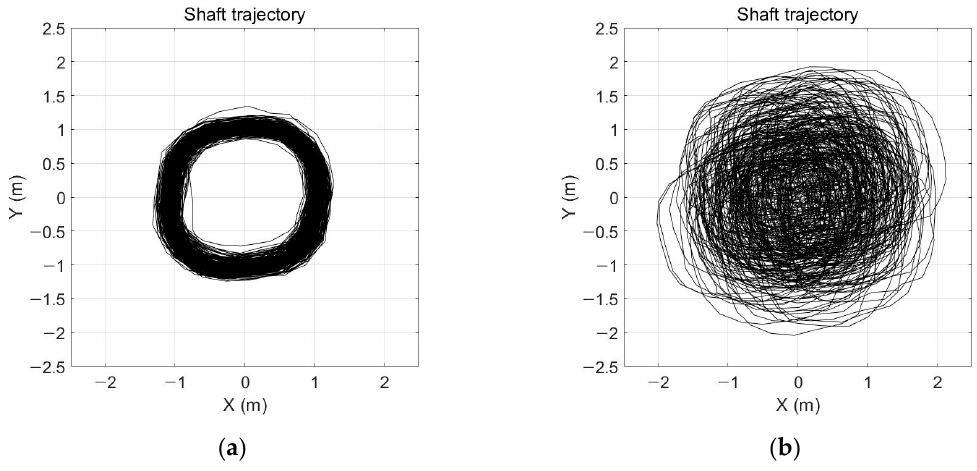
Figure 18. Shaft trajectory data from the ( a ) air test and ( b ) S-CO 2 test 1 at 30,000 rpm. From the data, 𝐹 (cid:3013)(cid:3022)(cid:3003) and 𝐹 (cid:3014)(cid:3003) were calculated. The 𝐹 (cid:3013)(cid:3022)(cid:3003) values with respect to the shaft’s position are shown in Figure 19, and 𝐹 (cid:3014)(cid:3003) values are in Figure 20. From Figure 19, the 𝐹 (cid:3013)(cid:3022)(cid:3003) acts in a direction almost parallel to the shaft velocity. The difference between test 1 and test 4 is that the radial components of 𝐹 (cid:3013)(cid:3022)(cid:3003) , 𝐹 (cid:3013)(cid:3022)(cid:3003),(cid:3045) in tests 1 and 2 are changed more frequently than in tests 3 and 4. This can be explained with Figure 7a, which de- scribes 𝐹 (cid:3045) with density change. From Figure 20a, 𝐹 (cid:3014)(cid:3003) has constant force to work against the shaft weight, 𝐹 (cid:3034)(cid:3045)(cid:3028)(cid:3049)(cid:3036)(cid:3047)(cid:3052) . 𝐹 (cid:3014)(cid:3003) plus 𝐹 (cid:3034)(cid:3045)(cid:3028)(cid:3049)(cid:3036)(cid:3047)(cid:3052) is plotted in Figure 20b to eliminate the con- stant force of the AMB. From Figure 20b, the 𝐹 (cid:3014)(cid:3003) acts as a second-order system which has stiffness and damping. However, 𝐹 (cid:3013)(cid:3022)(cid:3003) (Figure 19) does not act as a restoring force as 𝐹 𝐹 (cid:3014)(cid:3003) does. In rotor dynamics, the force acting like (cid:3013)(cid:3022)(cid:3003) is follower-force from the cross- coupled stiffness, which can increase the energy of the shaft motion with time [23].